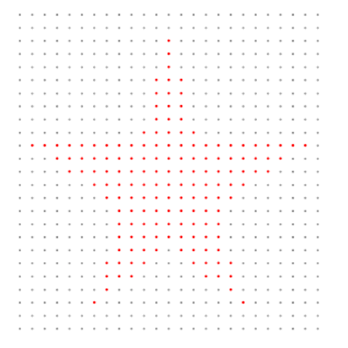
Figure 8. Schematic diagram of the design concept for a dotted-art heterogeneous MPP. In the diagram, the orange dots represent the larger holes of the pattern, and the grey dots represent the smaller holes that comprise the background part.